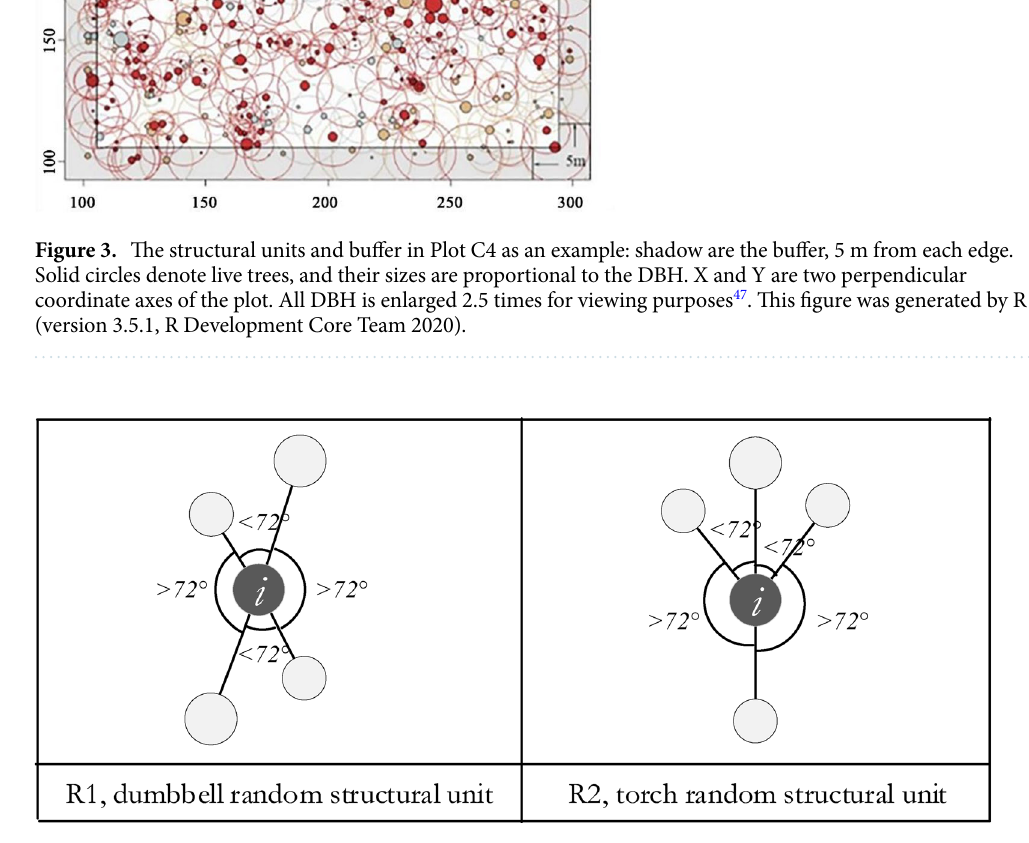
Figure 4. Different types of random structural units according to the uniform angel